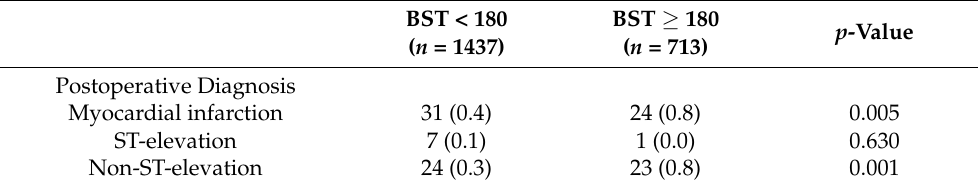
Table 4. Postoperative diagnosis in MINS